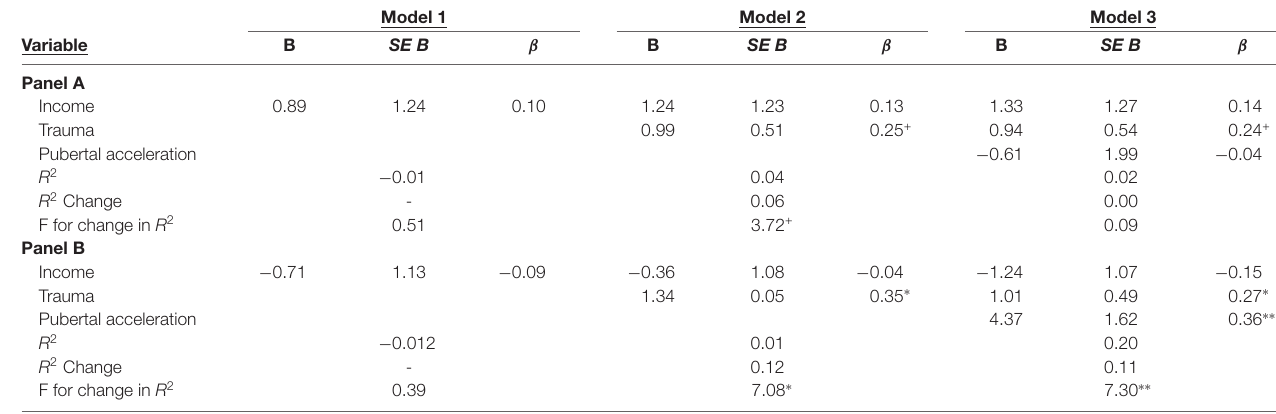
TABLE 3 | Hierarchical regression results for boys (Panel A) and girls (Panel B) for the dependent variable anxiety symptoms.